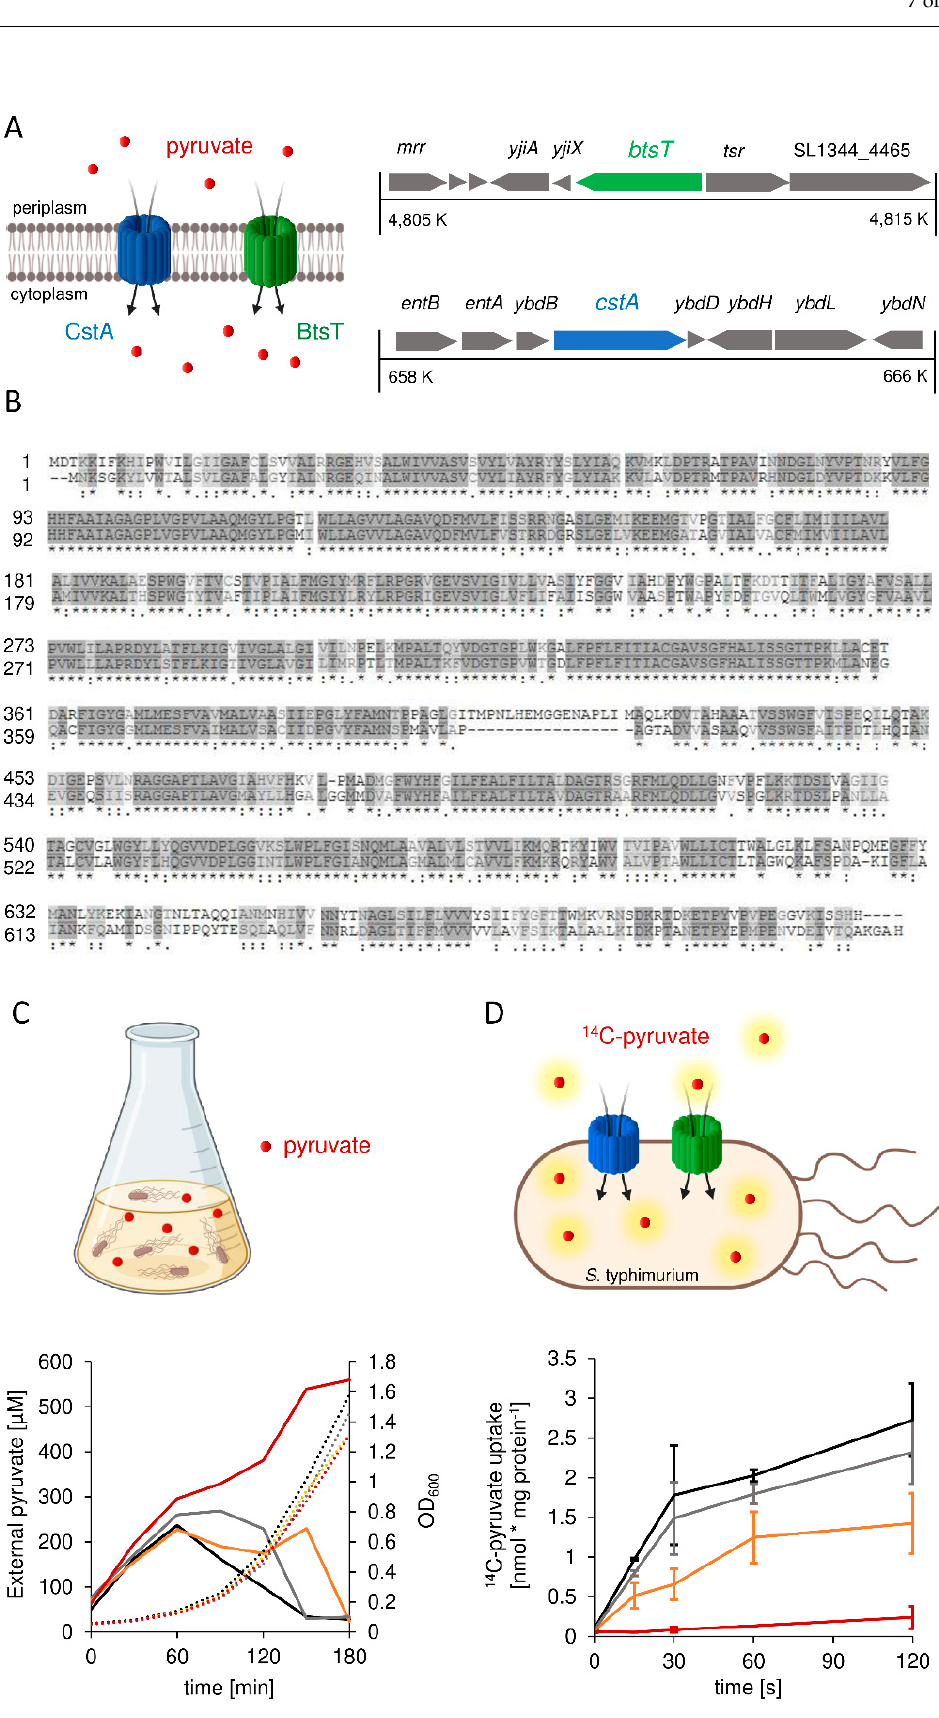
Figure 1. S. Typhimurium possesses two pyruvate transporters, BtsT and CstA. ( A ) Schematic illustration of the two transporters BtsT and CstA in S . Typhimurium responsible for the uptake of py- ruvate and the genetic context of their genes ( btsT (SL1344_4463), cstA (SL1344_0588)). ( B ) Protein sequence alignment of BtsT (upper line) and CstA (lower line), created with the online tool Clustal Omega. ( C ) Alterations of the pyruvate concentration in LB medium (solid lines) owing to overflow and uptake during growth (dotted lines) of S . Typhimurium SL1344 wild-type cells (black), Δ btsT mutant (yellow), Δ cstA mutant (grey), and Δ btsT Δ cstA mutant (red). Samples were taken every 20 min. ( D ) Time course of [ 14 C]-pyruvate (10 μ M) uptake by intact cells at 18 °C: SL1344 wild-type